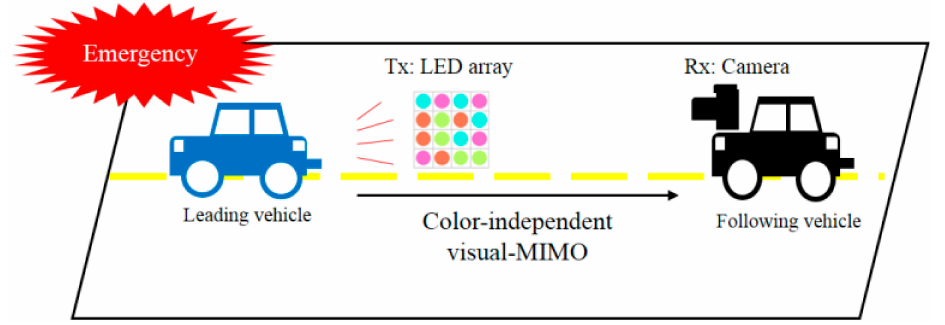
Figure 14. Example of V2X communication